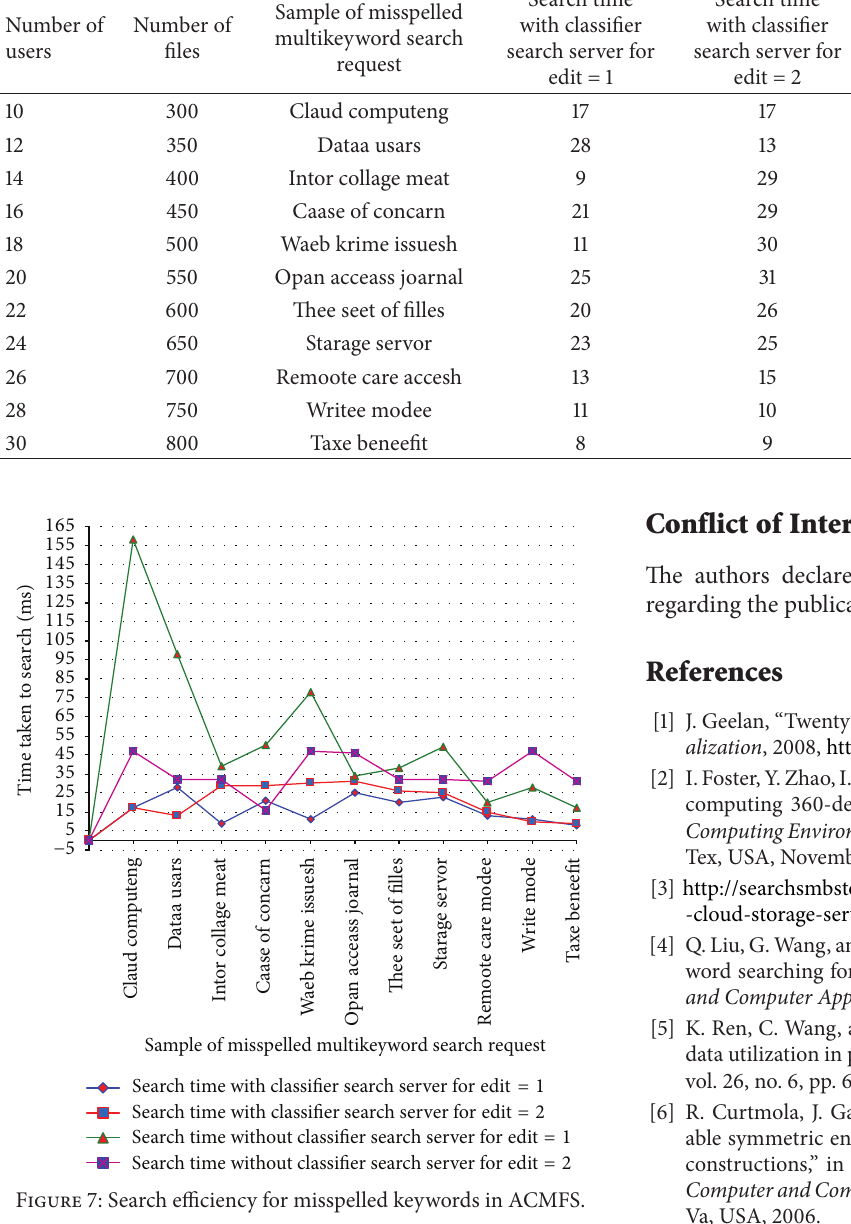
search request resulting in increased data utilization in terms of number of files retrieved for the corresponding